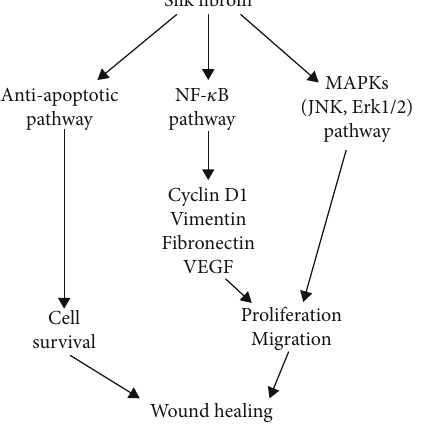
Figure 4: Biological pathways activated by silk fi broin to promote wound healing via enhancing cell viability, cell proliferation, and migration (adopted from Sultan et al.